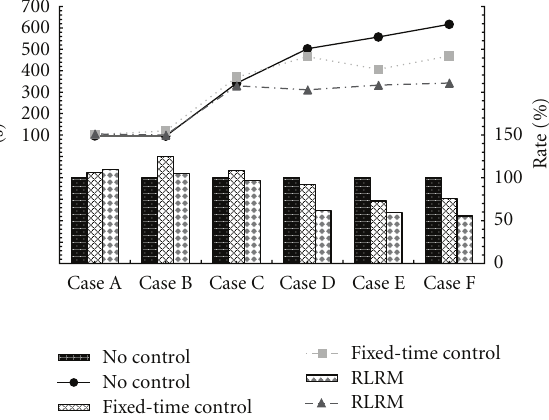
Figure 6: Average speed and its rate compared to no control.